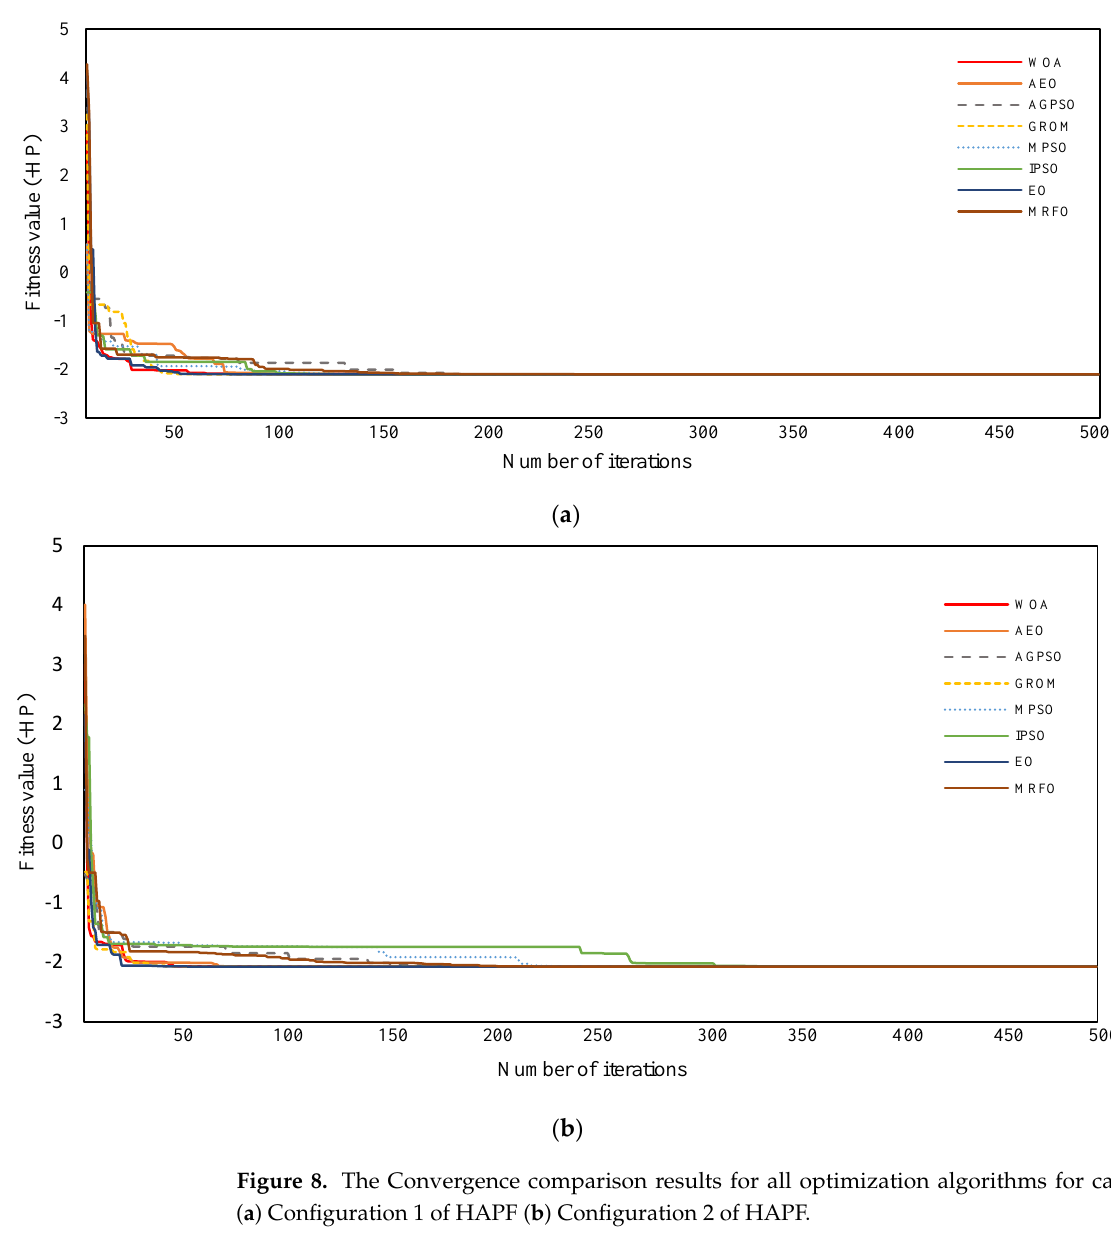
Table 6. The statistical analysis results of all optimization algorithms for the different HAPF sys- 380 tems.